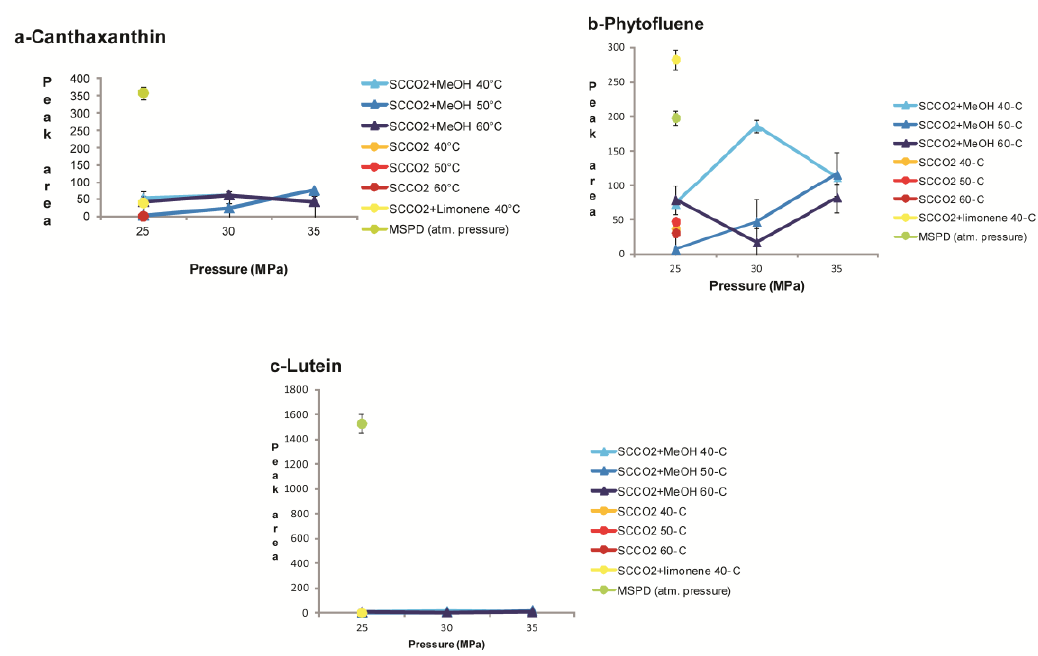
Figure 2. Extraction yields (average peak area ± standard error) of ( a ) canthaxanthin, ( b ) phytofluene, and ( c ) lutein obtained with SFE and MSPD.